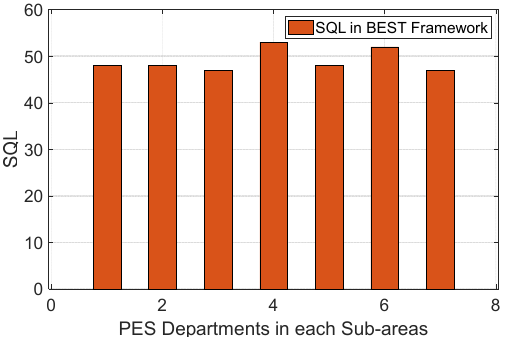
Figure 8. Evaluation of SQL for PES departments.